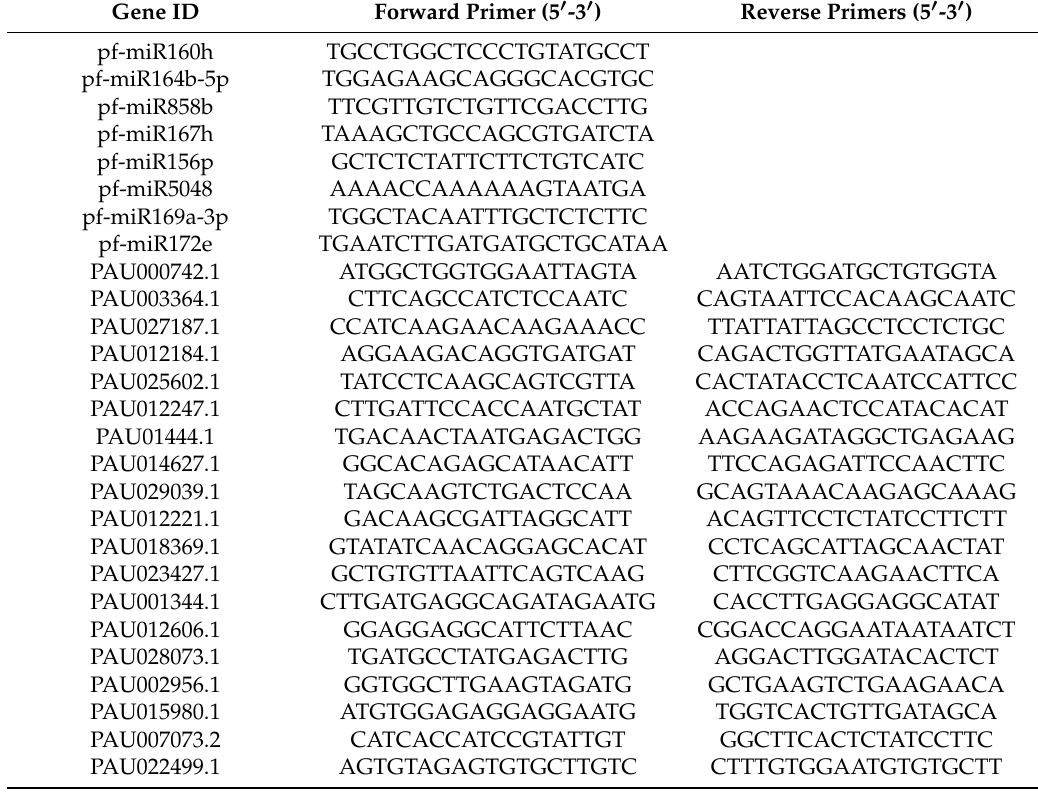
Table 1. Primers of quantitative PCR